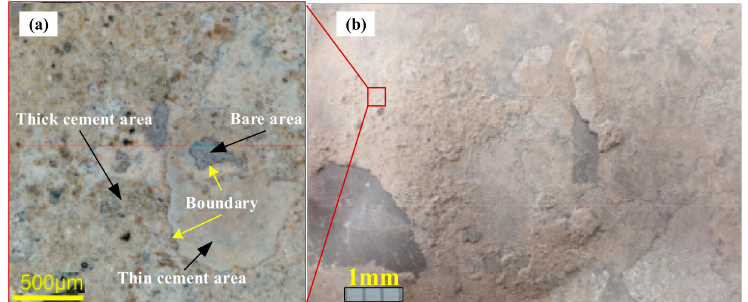
Figure 2. Morphology characteristics of concrete adhered to the surface of aluminum formwork ( a ) microstructure; ( b ) structure.